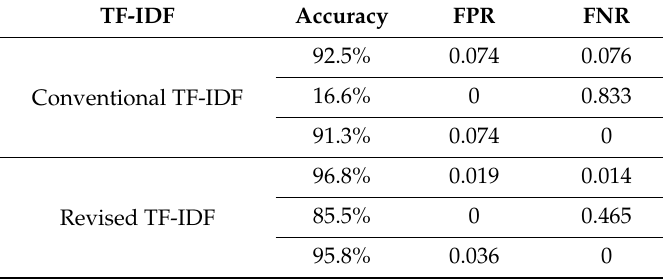
Table 8. Comparison performance of conventional TF-IDF and revised TF-IDF.